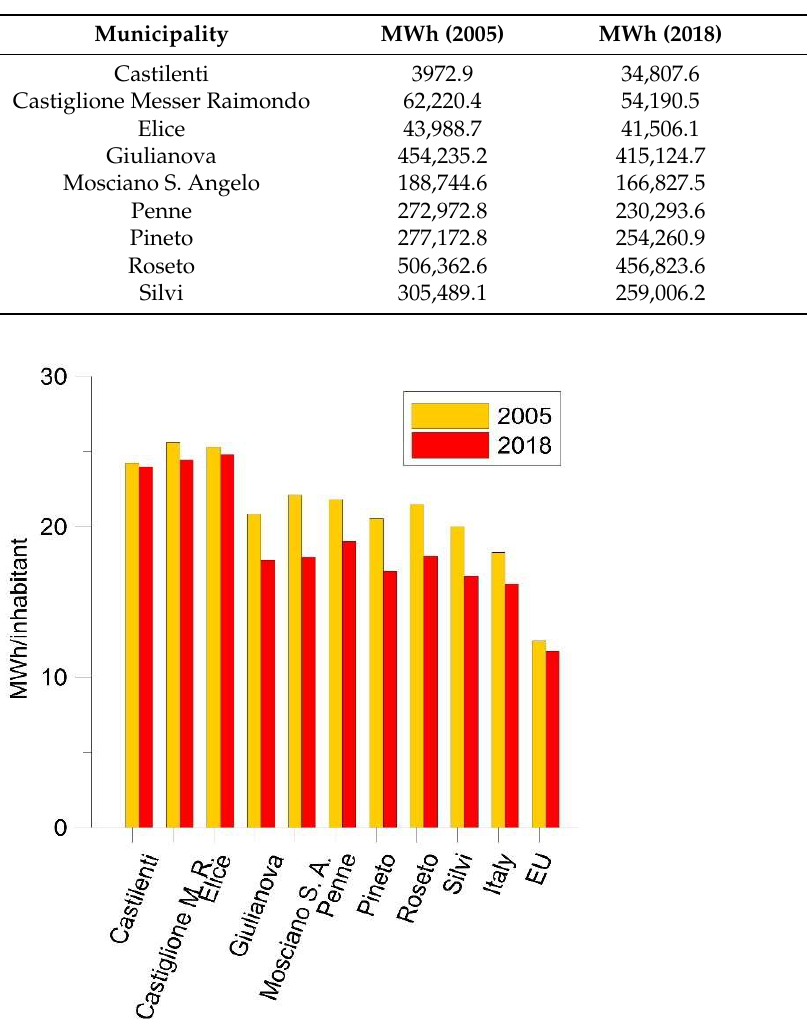
Table 6. Consumption for every city (MWh) and reduction as a percentage.